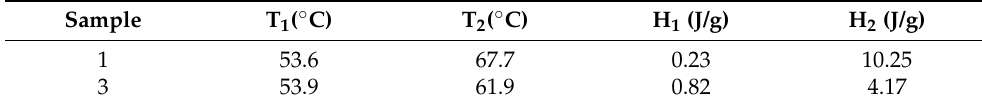
Table 5. Melting temperatures and enthalpies of retinol-loaded lipid nanoparticles.